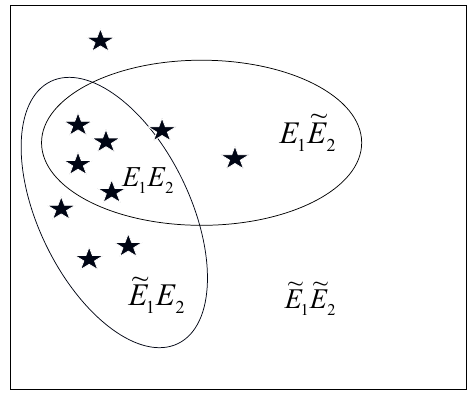
Fig. 3. Schematic diagram showing mineral deposits ( D ) shown as stars and two binary maps partitioning the study area into four subareas labeled as E 1 E 2 , E 1 ˜ E 2 , ˜ E 1 E 2 and ˜ E 1 ˜ E 2 ,